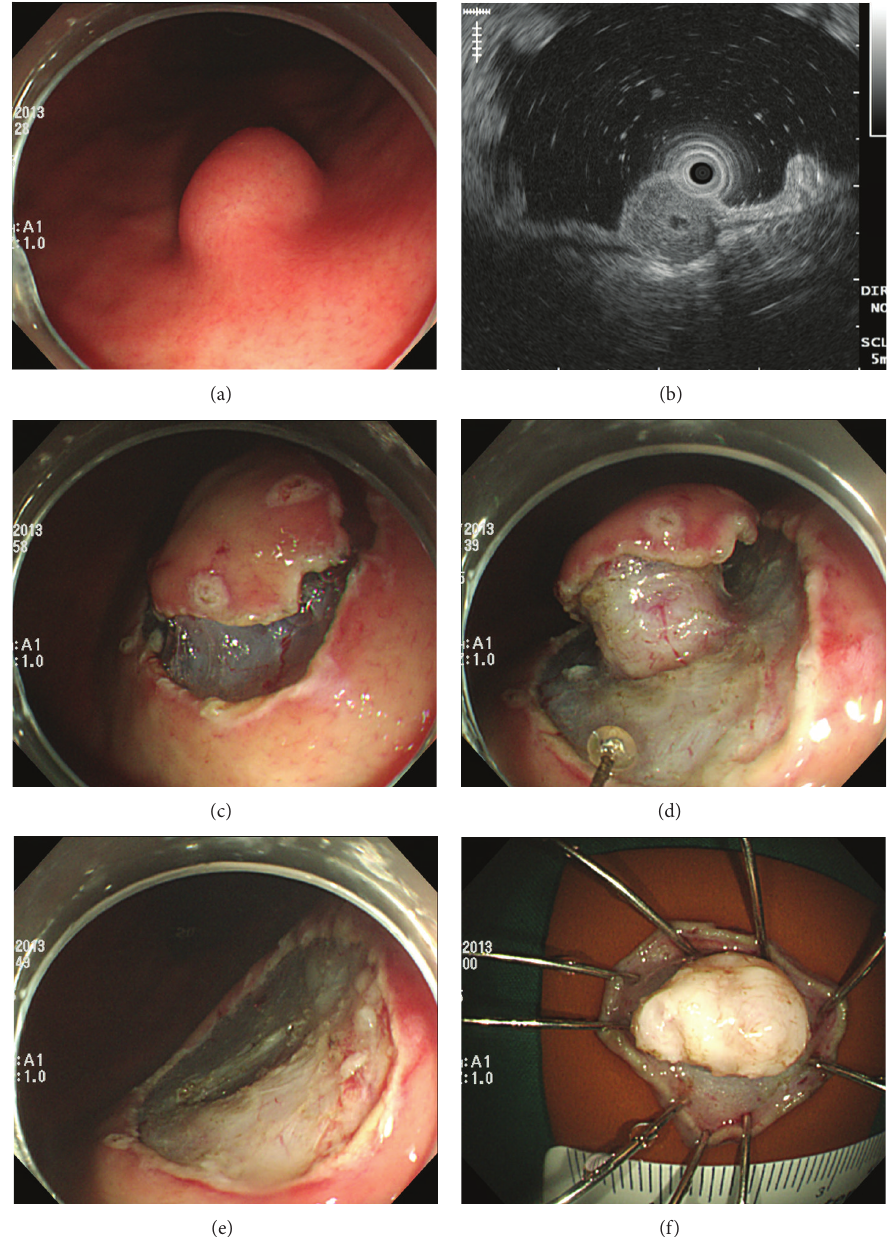
Figure 2: Endoscopic submucosal dissection of a gastric GIST. (a) A subepithelial tumor is observed in the middle third of the stomach. (b) The tumor originates from the muscularis propria layer on EUS. (c) After marking, circumferential precutting is performed. (d) Submucosal dissection of the tumor is performed using an IT knife. (e) The lesion is removed completely. (f) Inner surface of the resected specimen.